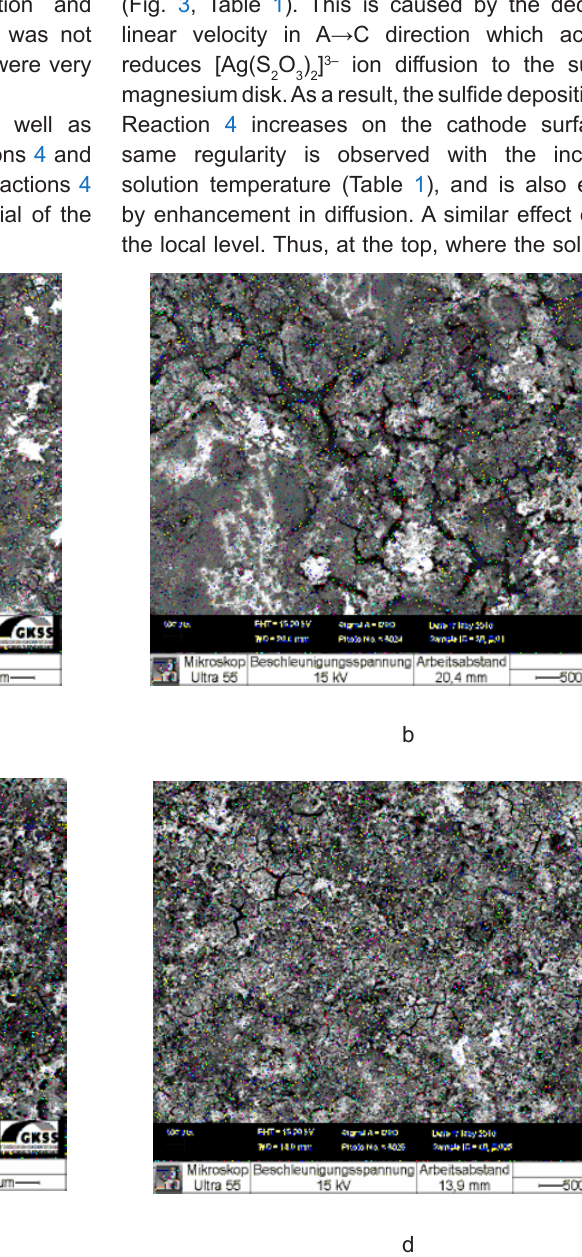
O ) ] 3– (b) solutions. Operation 2 3 2